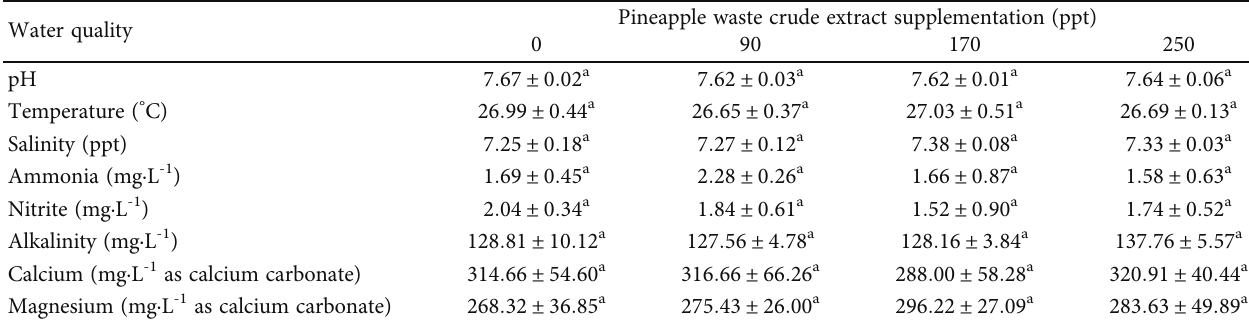
Table 3: Water quality of Paci fi c white shrimp cultured by fed with pineapple waste crude extract supplementation diet at di ff erent levels for 80 days.